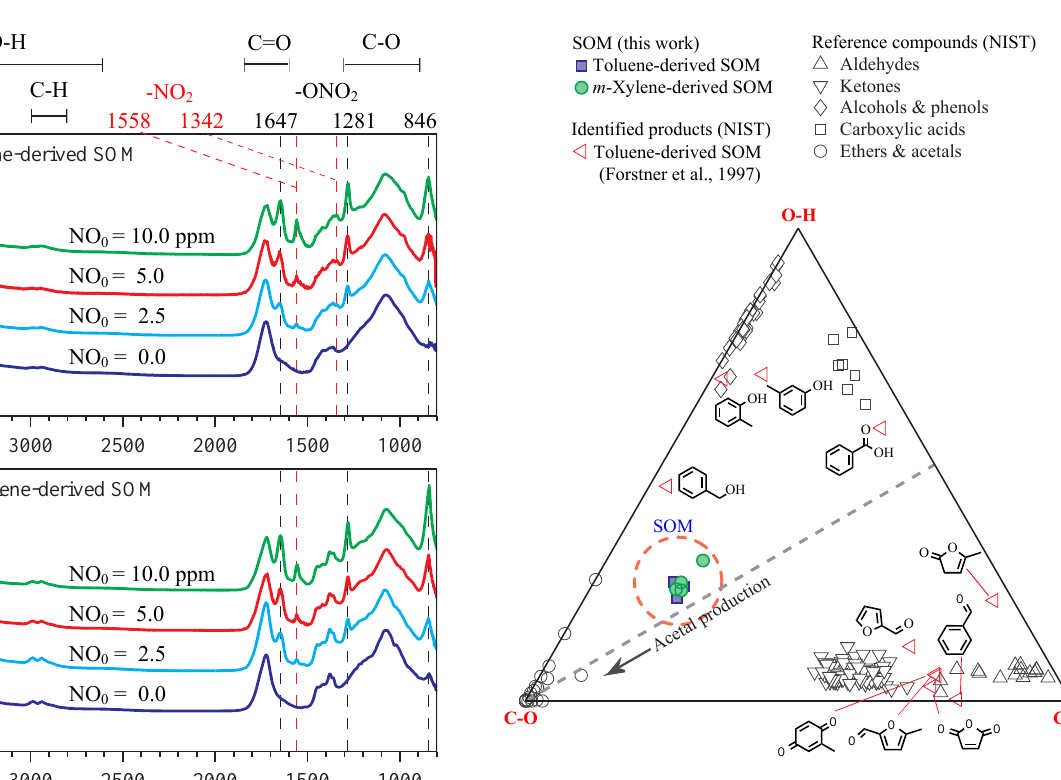
Figure 7. Ternary diagram representing the relative areas of O–H, C–O, and C = O bands for aromatic-derived SOMs. Data for ref- erence compounds in the NIST database, as well as of individual products reported in the literature for toluene-derived SOM, are also shown for comparison. The arrow illustrates the direction of particle-phase reactions. See Sect. S2 in the Supplement for further explanation of this